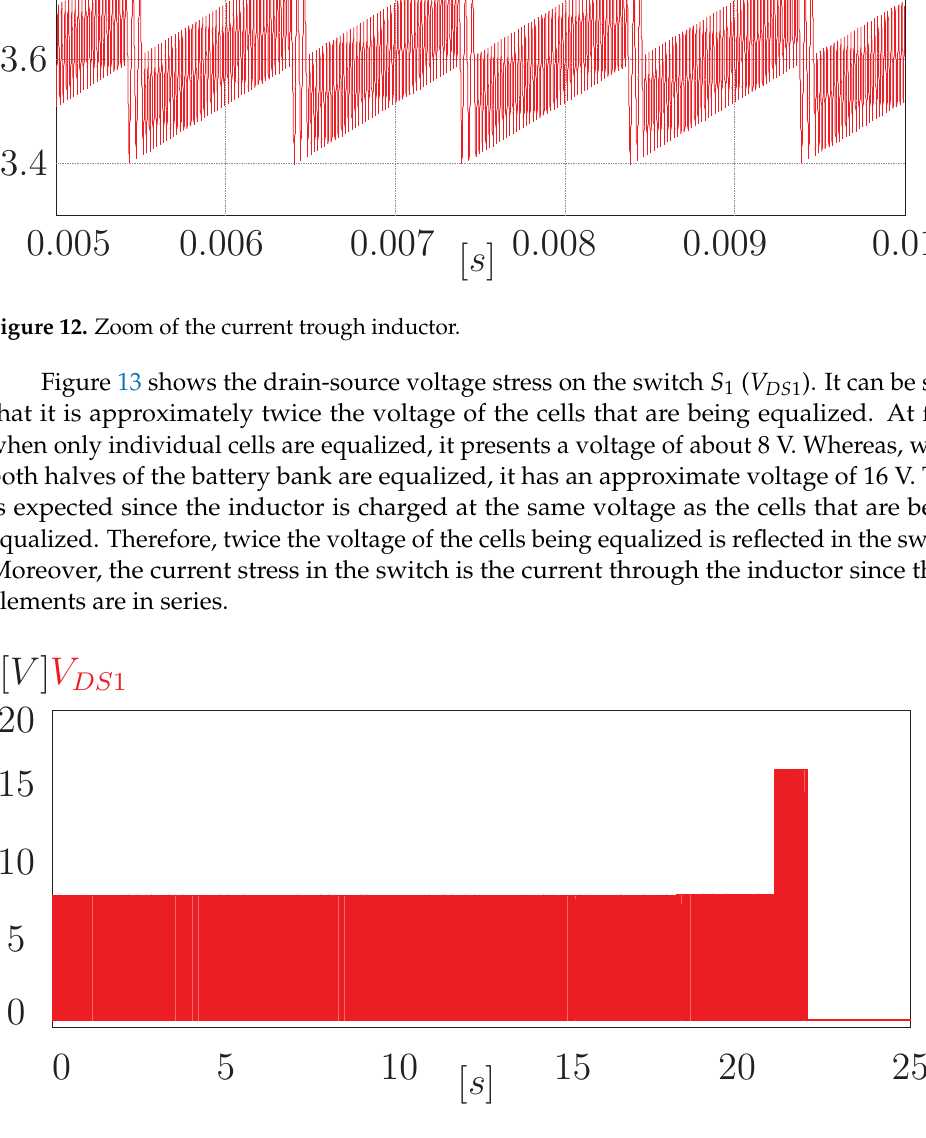
Figure 13. Voltage in the switch S 1 through the equalization